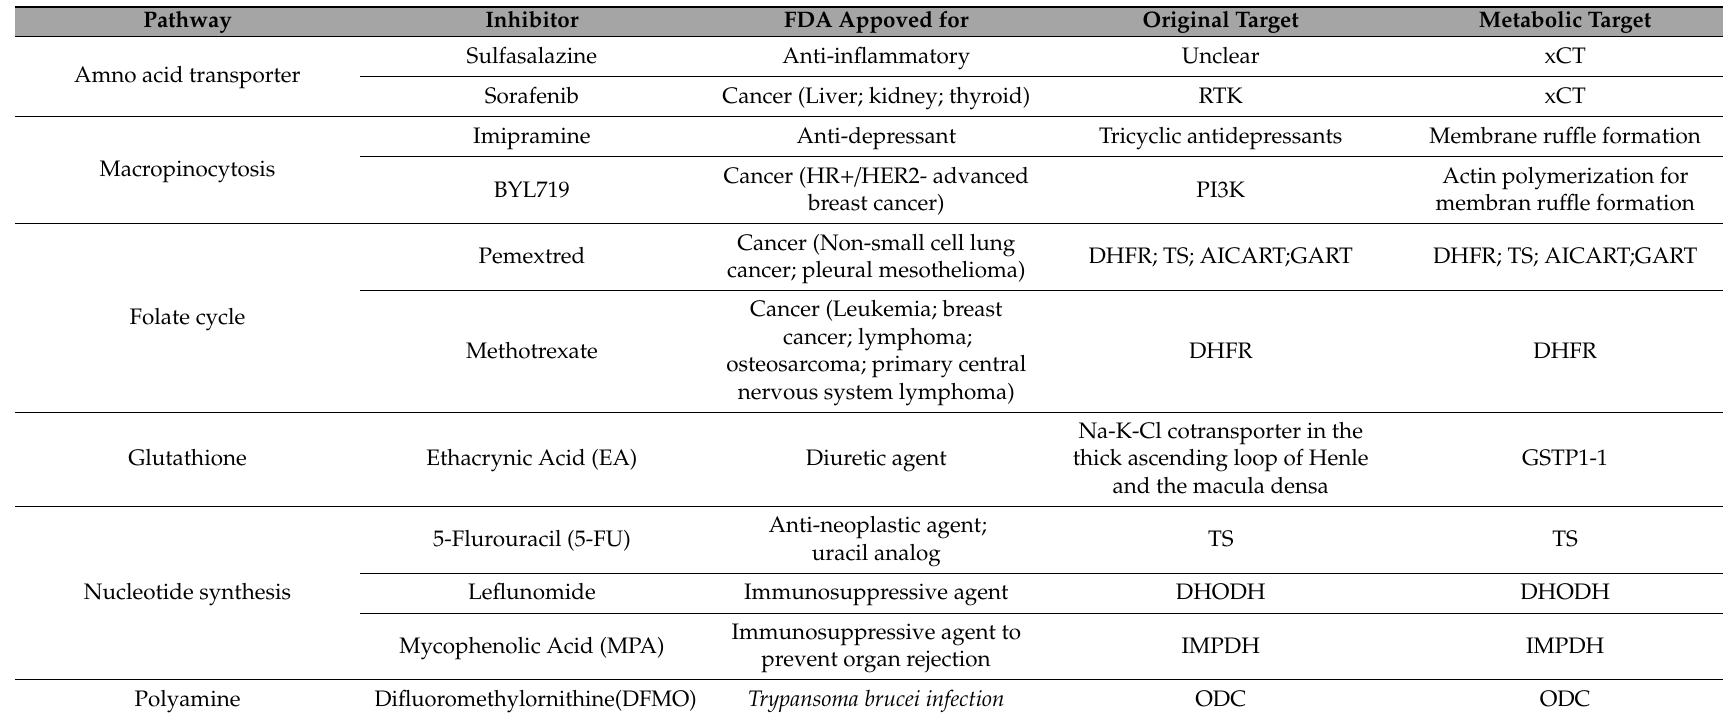
Table 2. FDA approved cancer therapeutics targeting amino acid